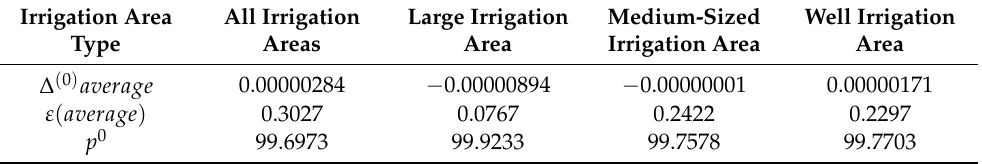
Figure 8. Relative error values (𝜀(𝑘)) of various types of irrigation areas. Average relative error ε ( average ) = 1 ( 1 − ε ( average ) , and the average relative error ε ( average )) of various types of irrigation areas are shown in Table 4. Table 4. Average relative error ε ( average ) and model accuracy of various types of irrigation